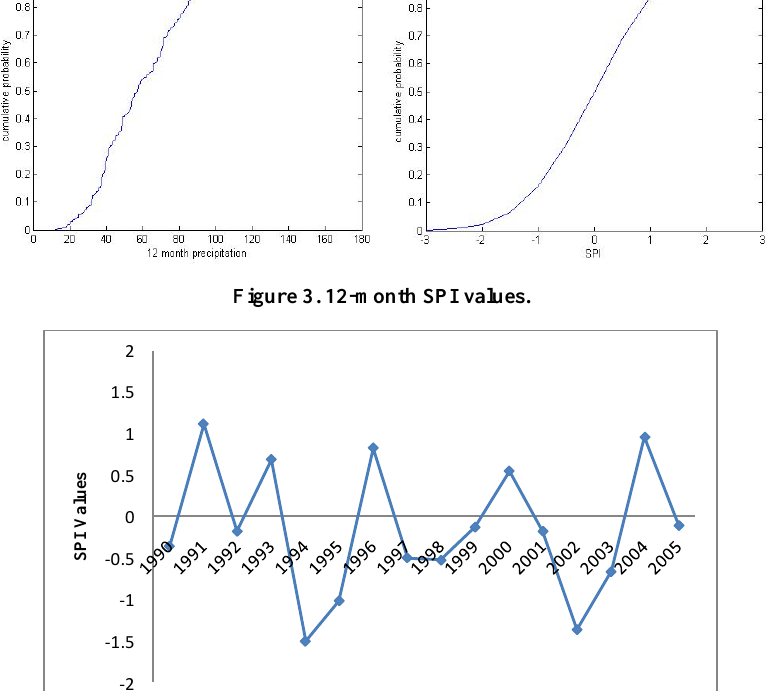
Figure 2. 6-month SPI values.